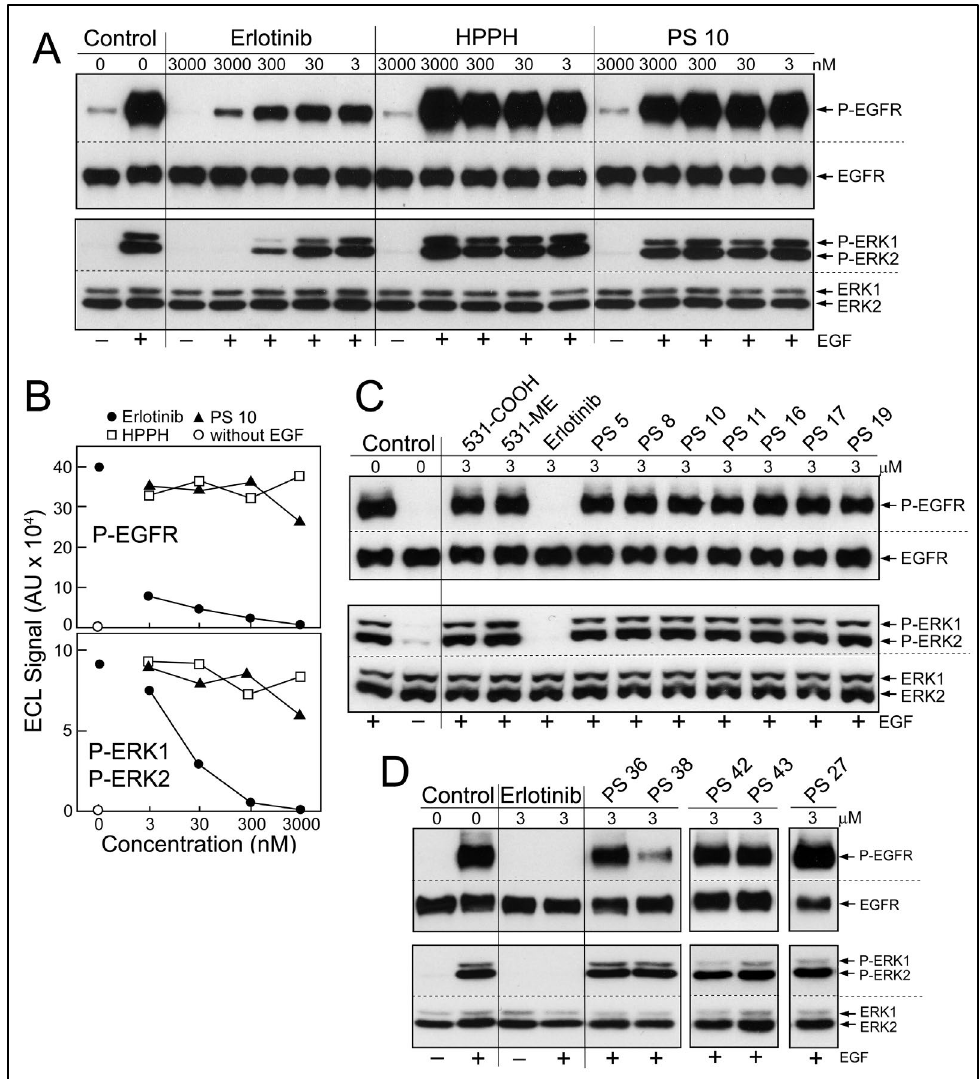
Figure 4. Effect of erlotinib and erlotinib conjugates on EGFR kinase activity. ( A ) HNT1 cells (p 186) treated for 15 min in serum-free media with increasing concentration of erlotinib and the PSs indicated at the top, followed by 15 min incubation with EGF (100 ng/mL). The cells were immediately lysed and aliquots of the cell extracts analyzed by Western blotting for the indicated proteins. ( B ) The immunodetectable signals (enhanced chemiluminescence, ECL) of the bands representing phosphorylated EGFR and ERK1/2 in “A” were quantified. ( C , D ), In two separate sets of experiments, HNT1 cells (p 163 and p 164) were treated for 24 h with media containing 10% FBS and the indicated compounds listed at the top. The function of the EGFR was assessed by treatment for 15 min with EGF added to the same media. The levels of phosphorylated EGFR and ERK1/2 were determined by immunoblot analysis. PS 36 is the substrate to which erlotinib has been conjugated yielding PS 38, and PS 42 is the substrate for synthesis of PS 43.